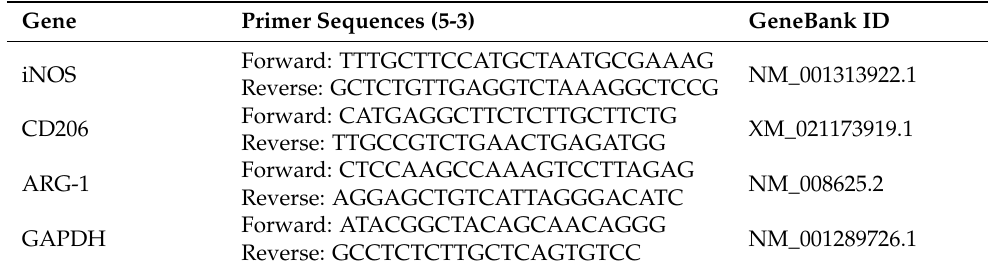
Table A1. Primer sequences used for